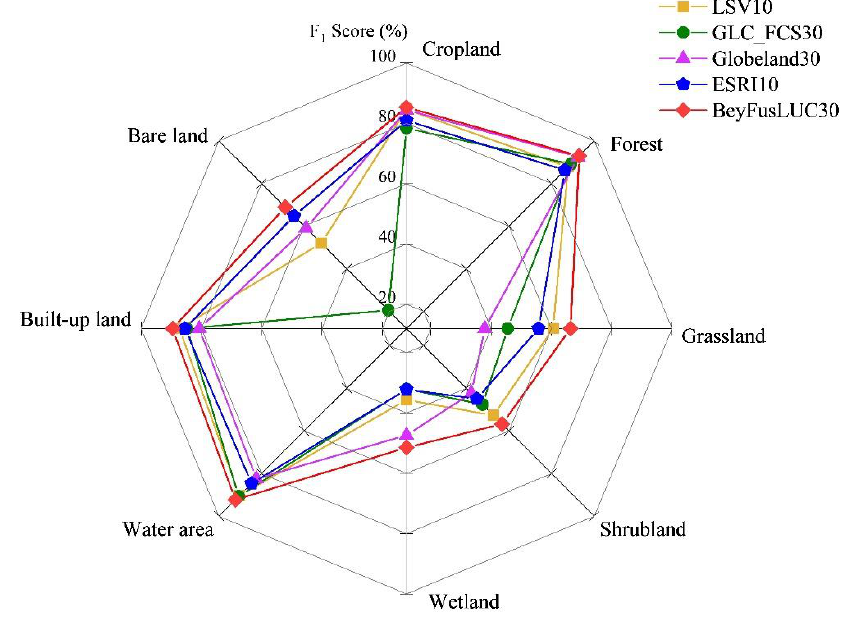
Figure 6. Comparison of F1 scores of various types in five